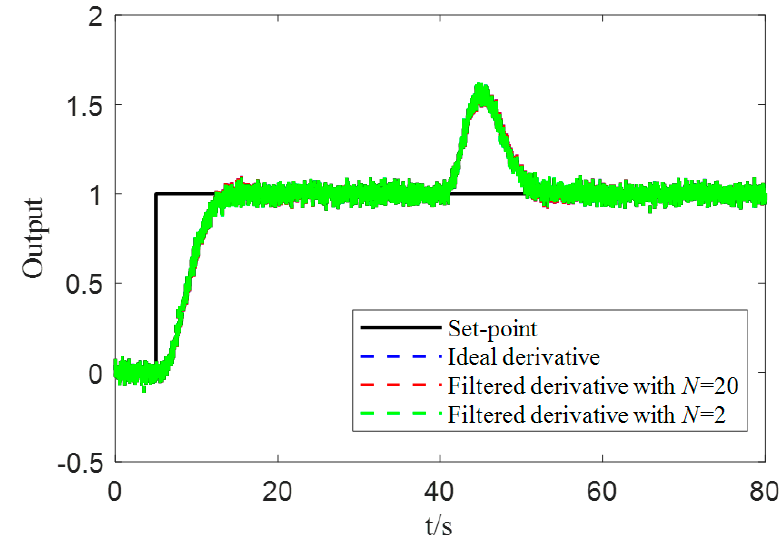
Figure 15. The output response for Example 1 with high-frequency measurement noise.